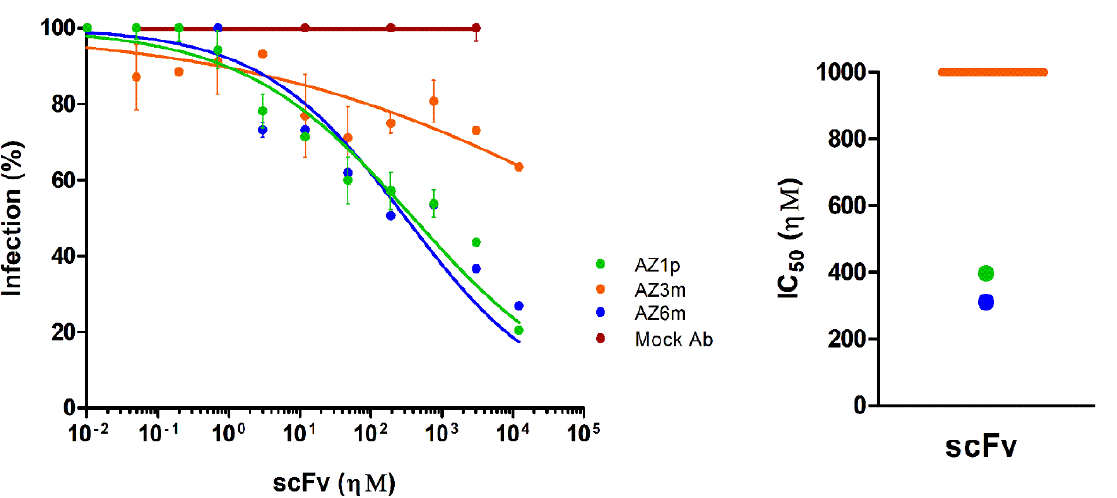
Figure 6. Neutralization of Zika virus infection. The ability of scFvs to neutralize the Zika virus was measured in a plaque reduction neutralization test (PRNT). On the left, the percentage of infection was calculated by the ratio between the number of plaques formed in the presence and absence of recombinant antibodies. On the right, half-maximum inhibitory concentrations (IC 50 ) represent the means of replicates from at least two independent experiments. The representation of the IC 50 values was limited to 1 µ M. The IC 50 value of the AZ3m greater than 1 µ M was plotted as the limit (orange line). An unspecific scFv was used as a negative antibody (Mock Ab).